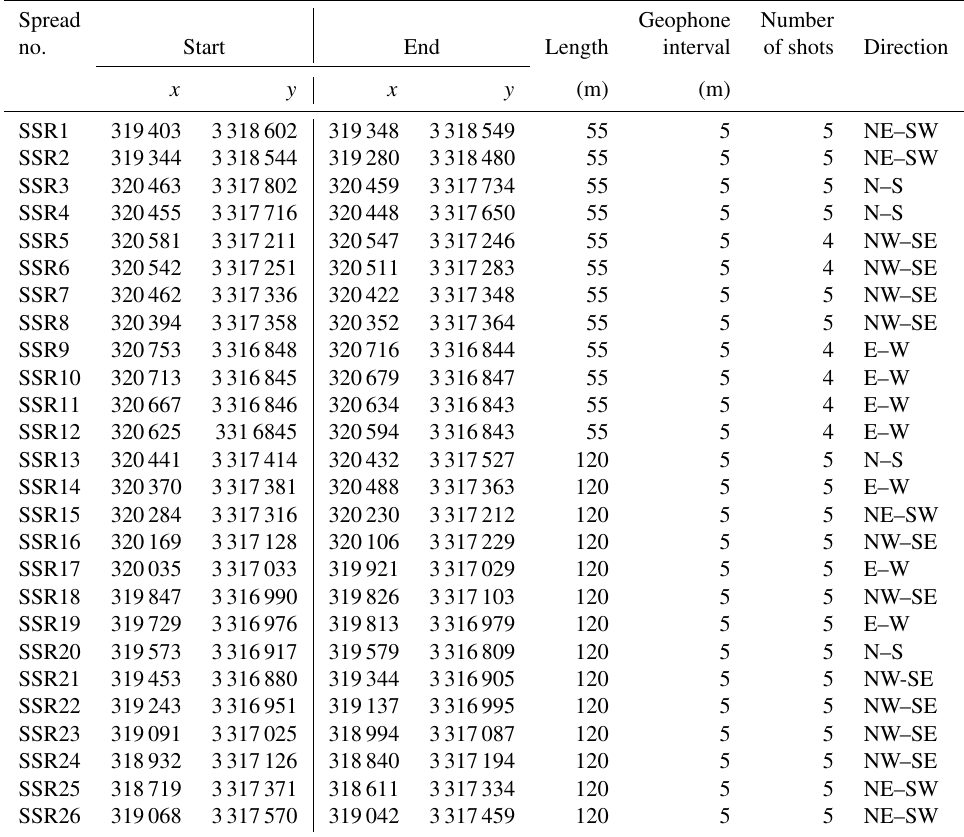
Table 2. Main characteristics of SSR